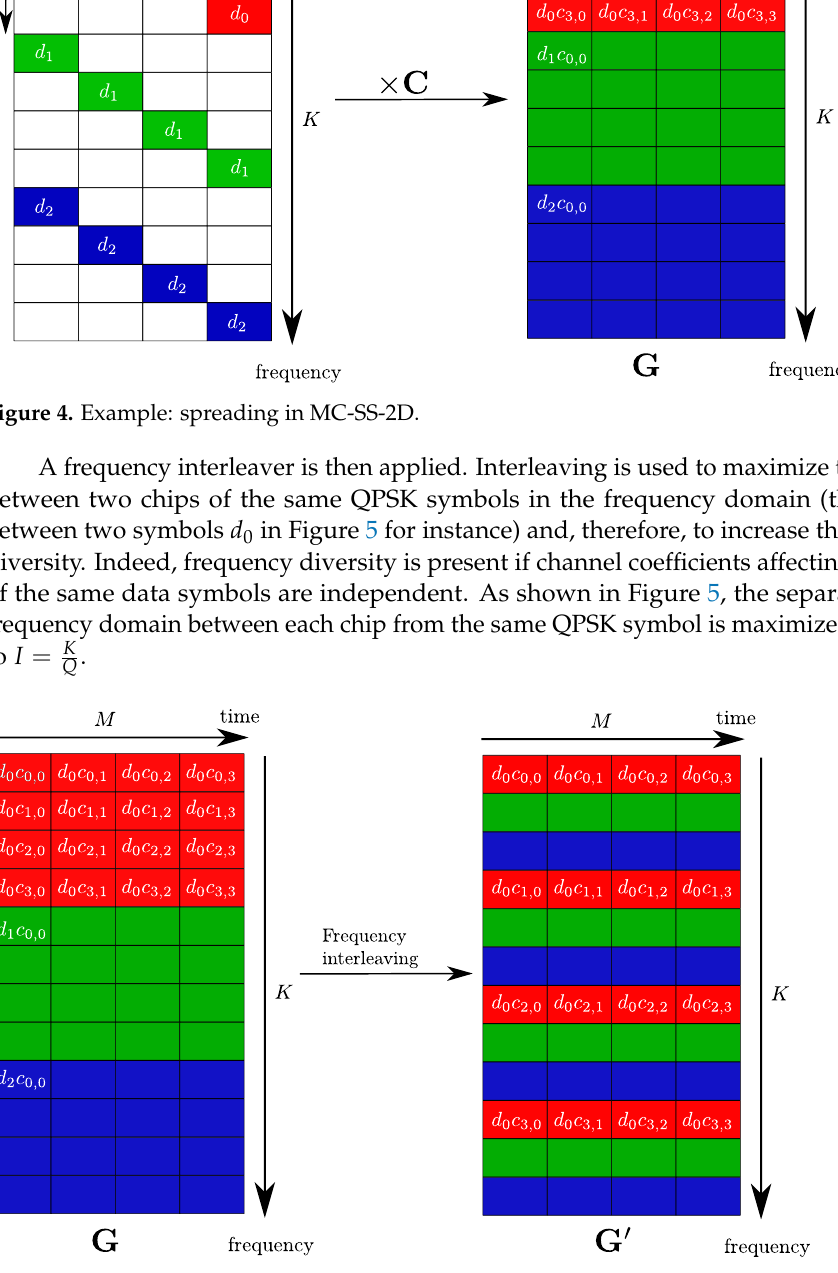
Figure 5. Example: frequency interleaving in